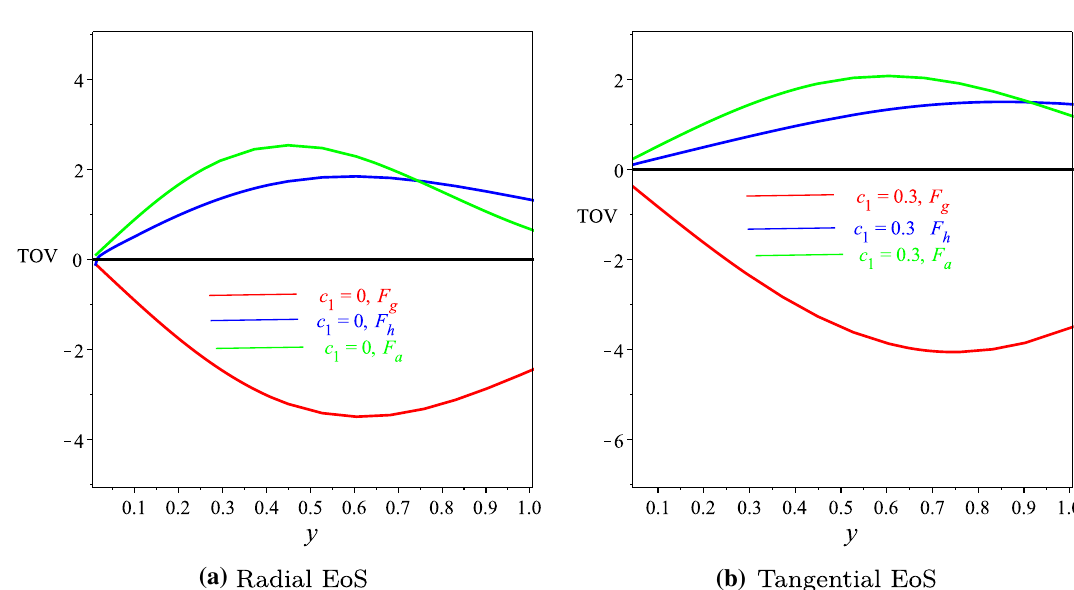
Fig. 8 The radial and transverse EoS when c 1 = 0 and c 1 = − 0 . 01